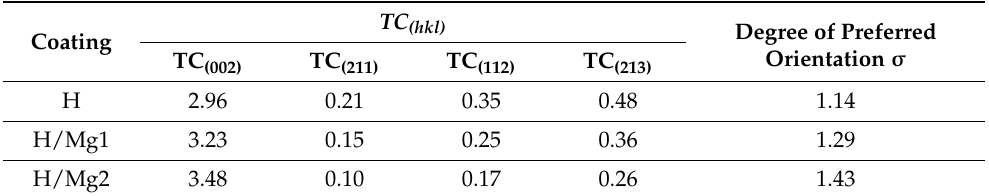
Table 4. Texture coefficients and degree of preferred orientation for the undoped and Mg-doped HAp